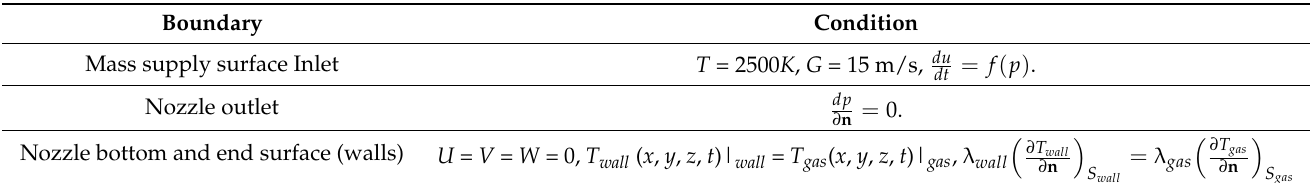
Table 1. Boundary